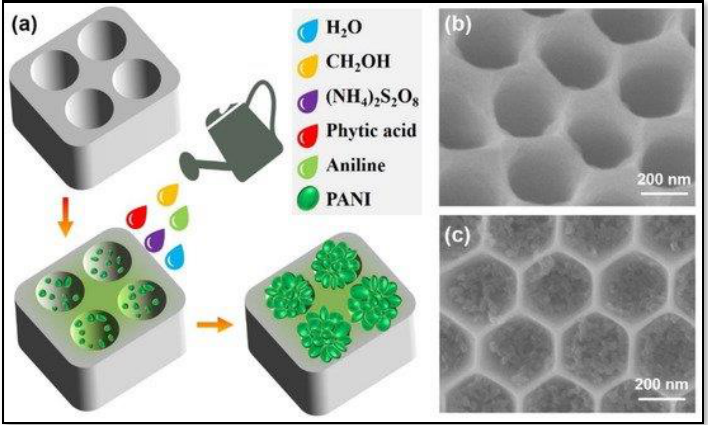
Figure 20. ( a ) Schematic illustration of the preparation of photothermal materials PANI on a porous anodic aluminum oxide (AAO) membrane. The SEM images of ( b ) AAO and ( c ) PANI-AAO. Re- printed with permission from Ref.